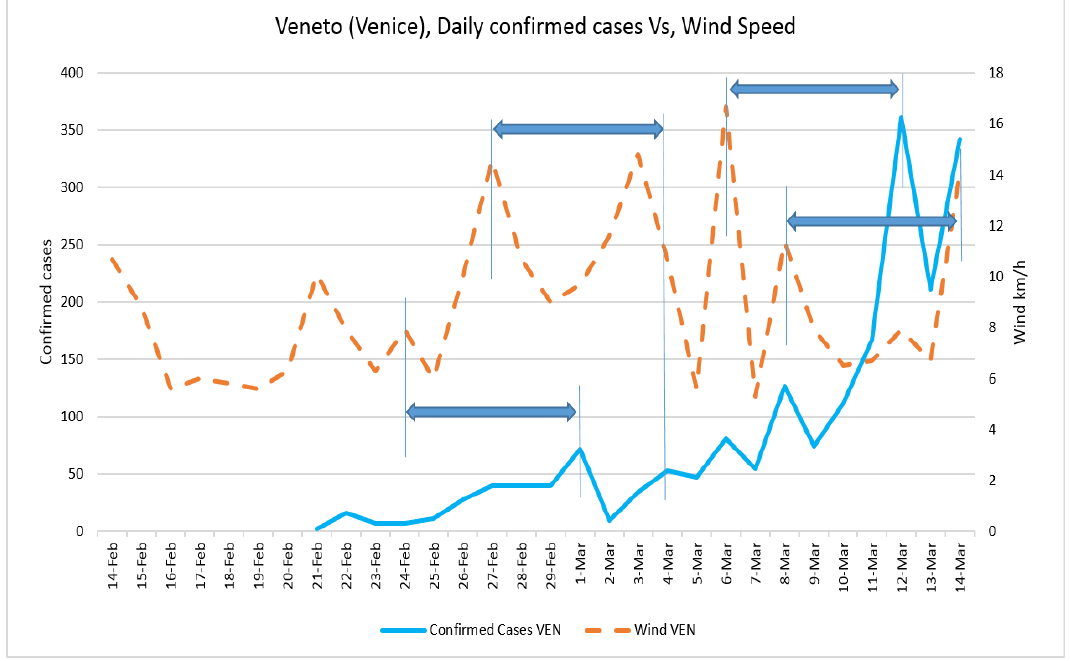
Figure 7. Daily confirmed cases of COVID-19 in Veneto and wind speed.